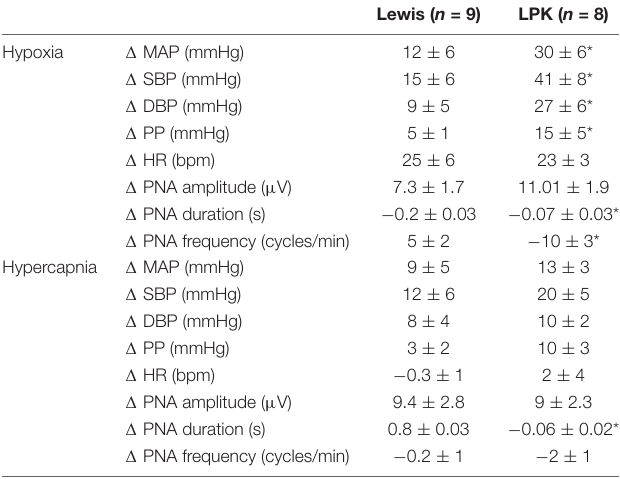
TABLE 3 | Effects of peripheral or central chemoreceptor stimulation on cardiorespiratory pattern in adult female Lewis and LPK